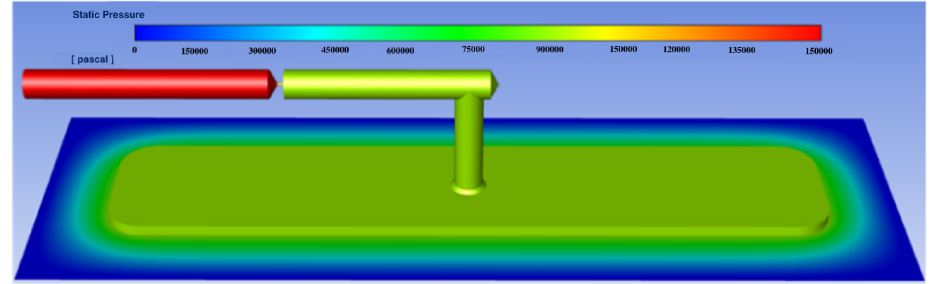
Figure 5. Pressure profile of bearing interior (Film thickness h = 25 µ m).